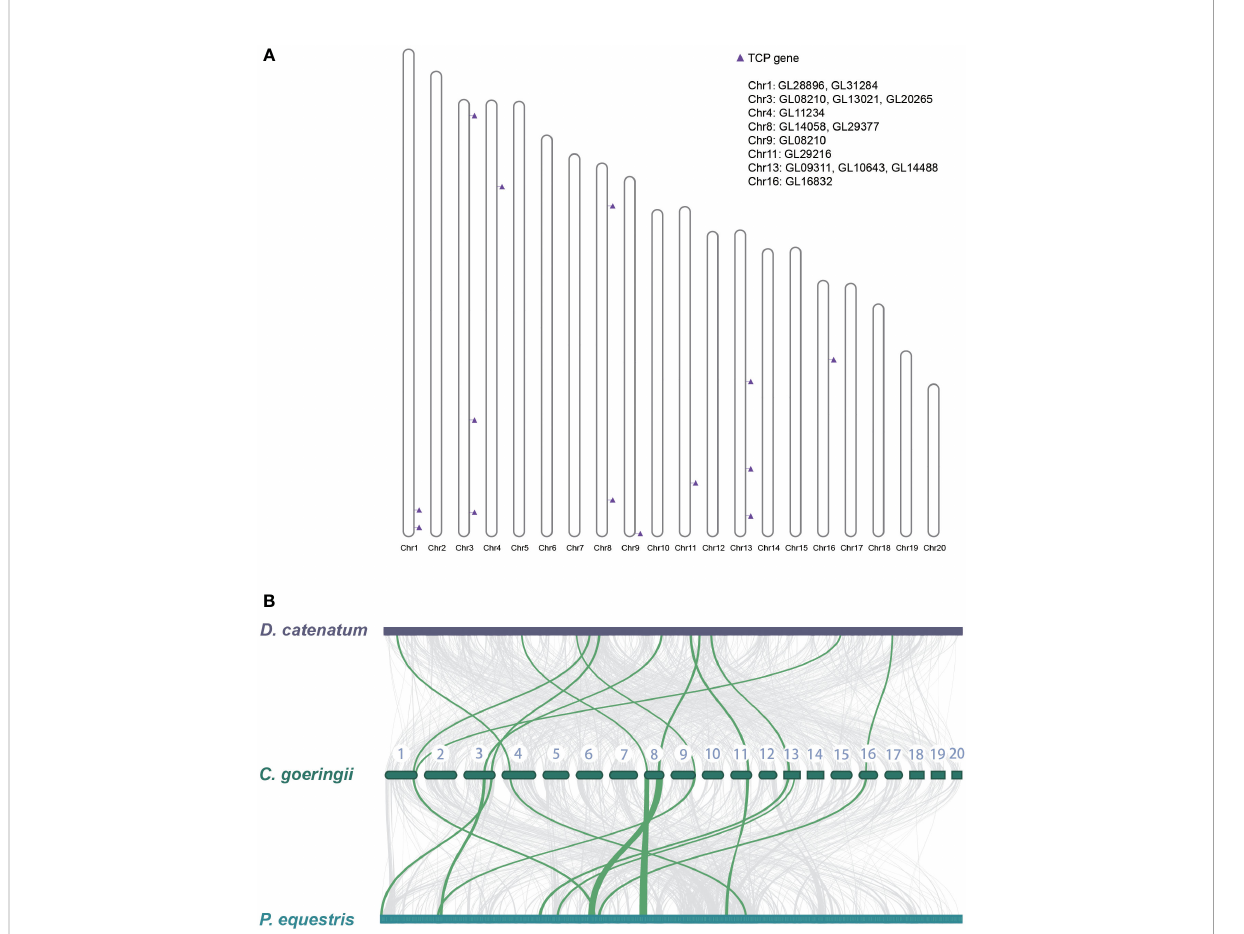
FIGURE 3 The TCP gene location on the chromosome of C. goeringii and collinearity between P. equestris and D . catenatum . (A) The chromosomal location of CgTCP genes. (B) The collinearity analysis suggested that the three orchids presented nearly one-to-one correspondence of TCP